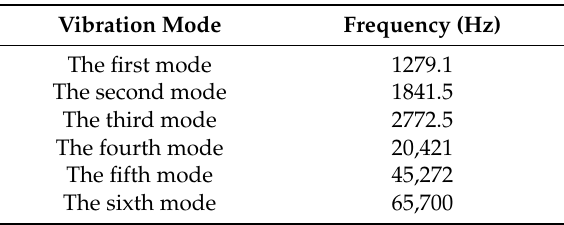
Table 1. The result of the modal analysis.